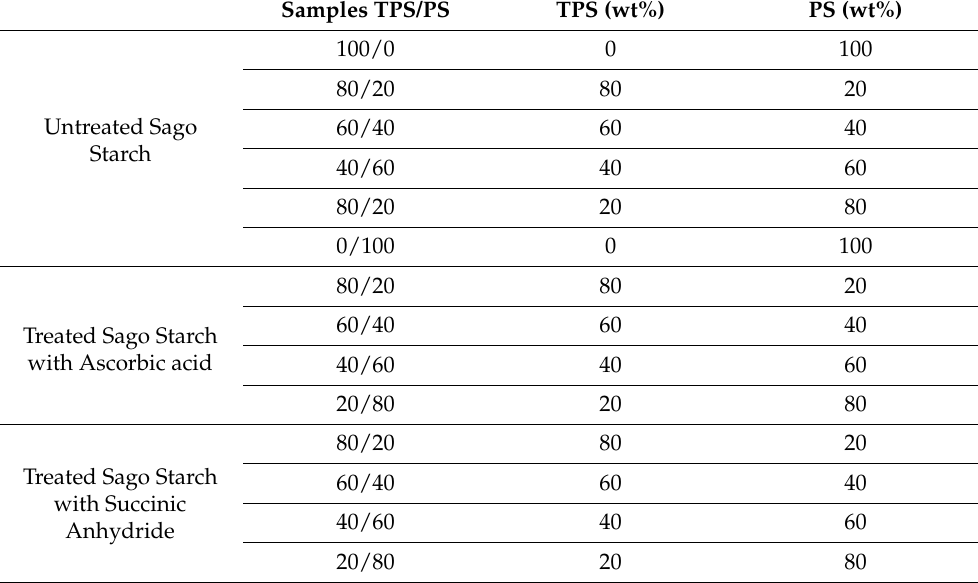
Table 1. Composition of TPS blended with PS in different weight